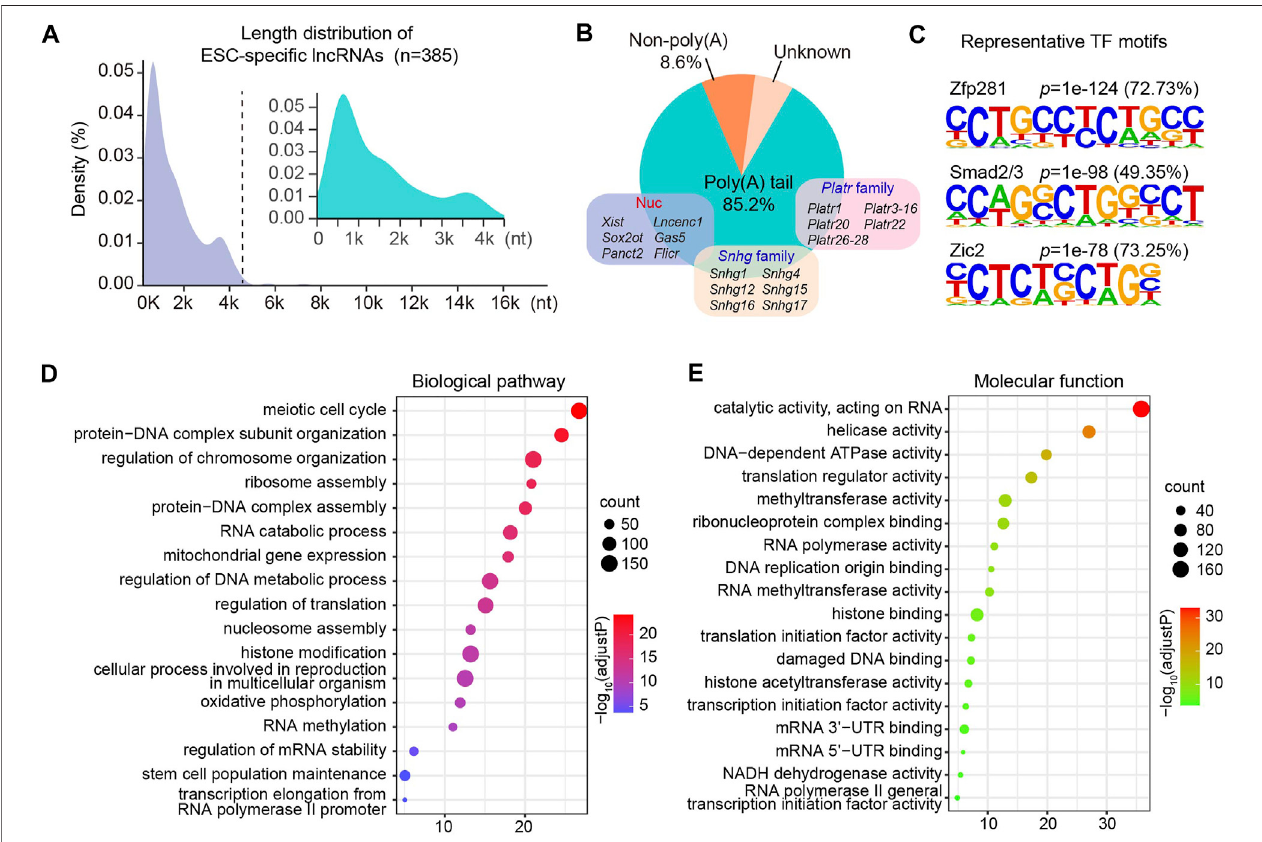
FIGURE 2 | Regulatory features and cellular functions of ESC-speci fi c lncRNAs. (A) Length distribution of ESC-speci fi c lncRNA transcripts. (B) Polyadenylation features of ESC-speci fi c lncRNAs. (C) Motif enrichment analysis showing representative TF motifs identi fi ed in the promoter region of genes coding ESC-speci fi c lncRNAs. The selected motifs are linked to their corresponding TF. (D,E) Bubble plots show the biological pathways (D) and molecular functions (E) enriched by ESC- speci fi c mRNAs co-expressed with lncRNAs. The size of a bubble is proportional to the number of genes. The intensity of the circle color is corresponding to the signi fi cance level which is indicated as -log 10 (adjust p